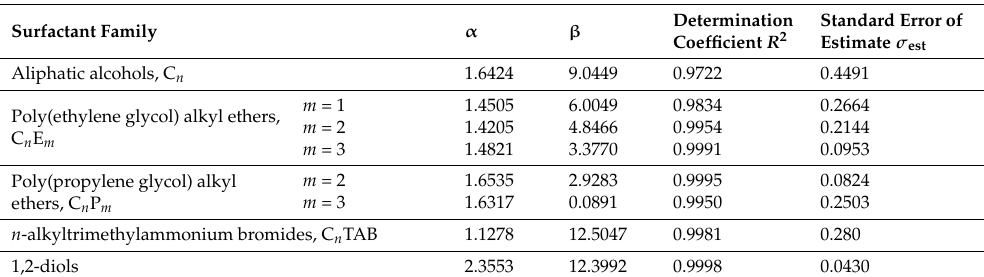
Table 2. Constants in linear trends in relationship between lnCMV and n (Figure 12, lnCMV = − α n + β ) that depend on frother family and goodness-of-fit statistics.